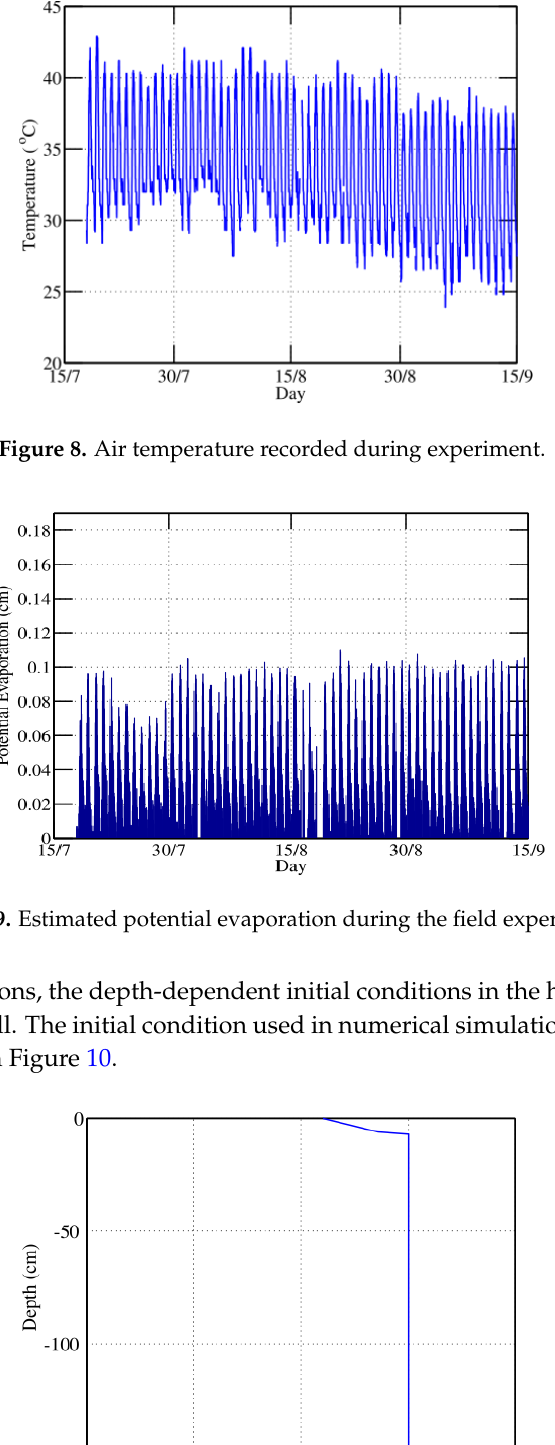
Figure 10. Soil moisture content recorded in the sand column at the beginning of the experiment.